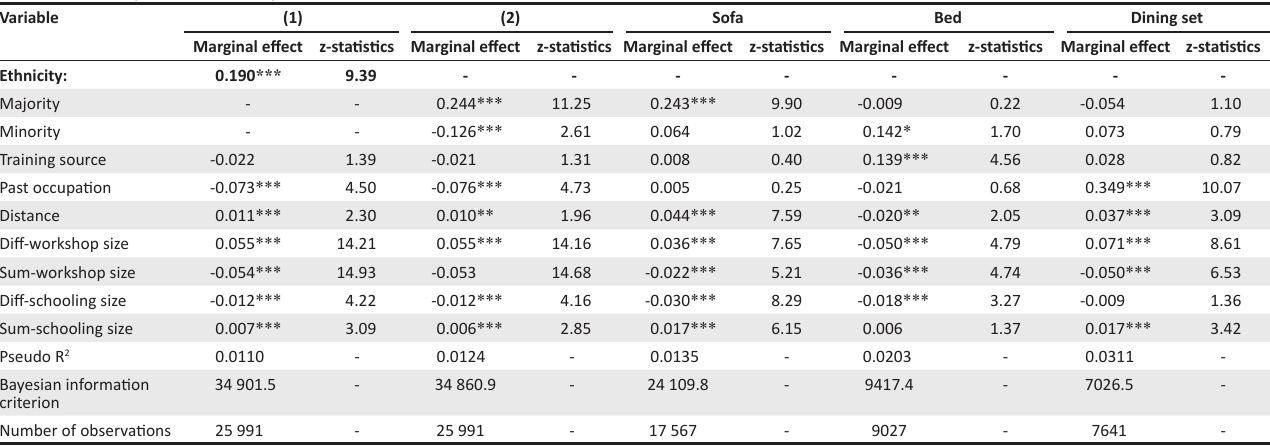
TABLE 3: Assembly skill and ethnicity. Variable (1) (2) Sofa Bed Dining